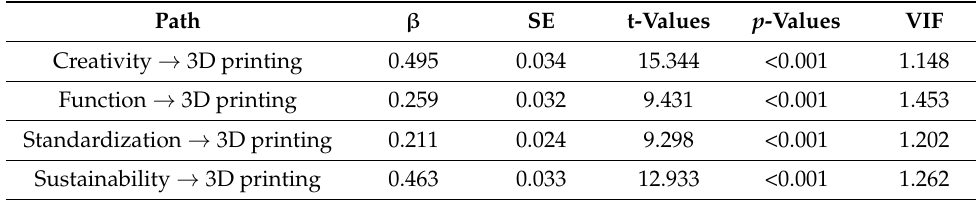
Figure 5. Bootstrapping analysis showing outer path indicating loading and p -values and inner weights with p -values. Table 8. Bootstrapping statistics for formative constructs.